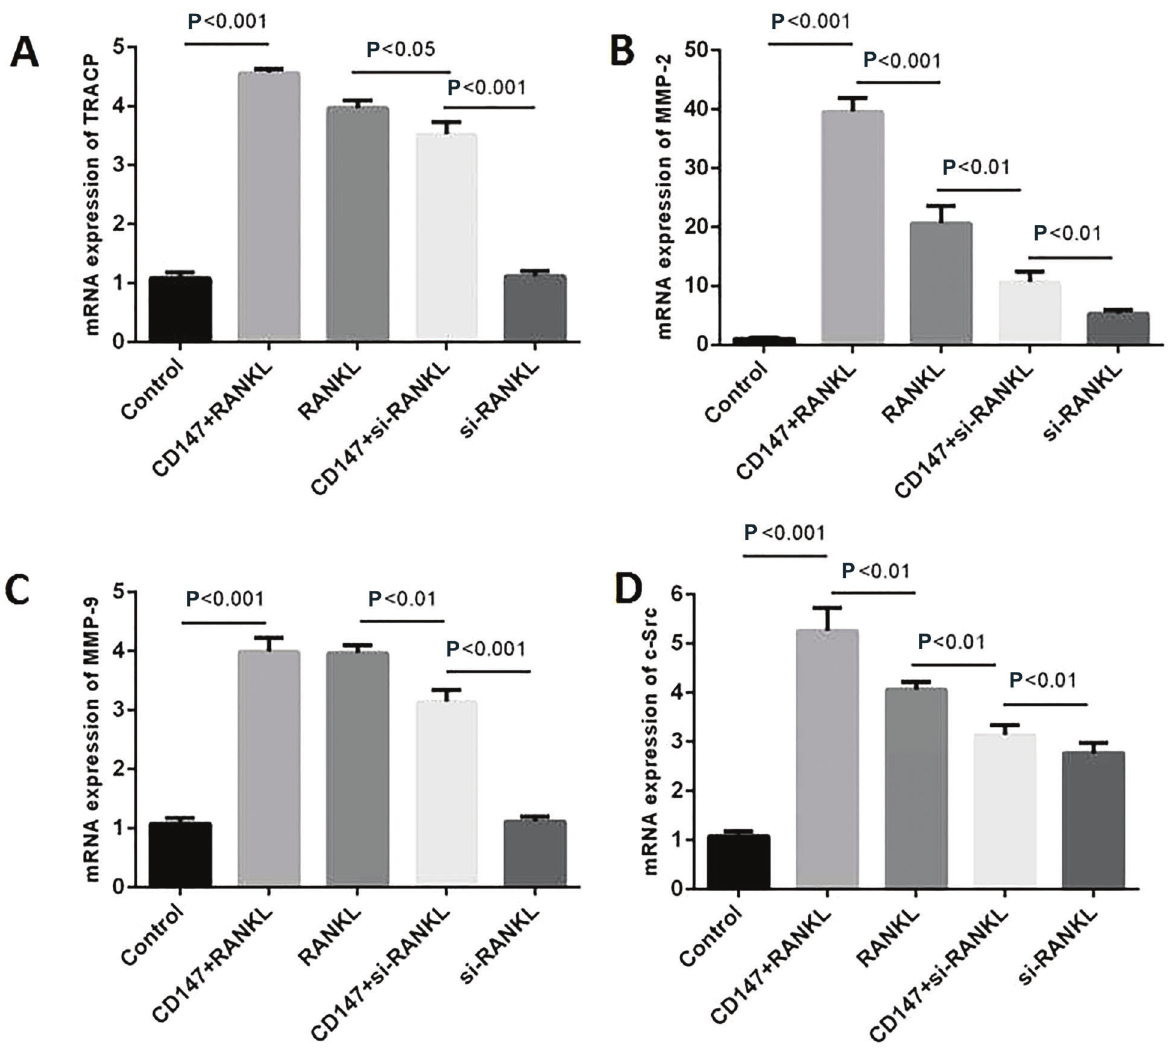
Figure 4. RT-PCR analysis of tartrate-resistant acid phosphatase (TRACP), matrix metalloproteinases (MMP)-2, MMP-9, and c-Src with over-expressed CD147 gene in osteoclasts. GAPDH was used as reference gene. Data are reported as means ± SD and compared with the t -test. RANKL: receptor activator of NF-kB